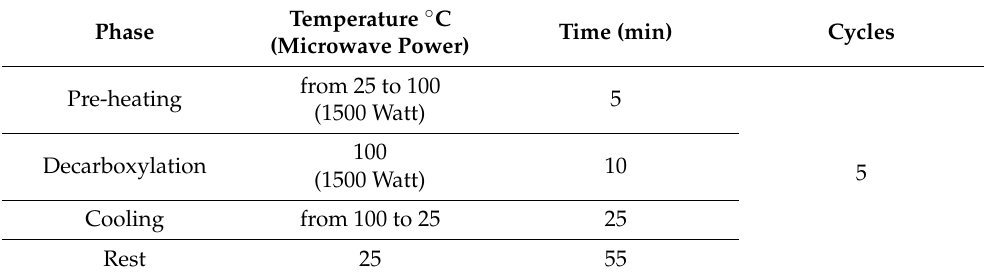
Table 2. Cyclic decarboxylation applied in the CERFIT method.